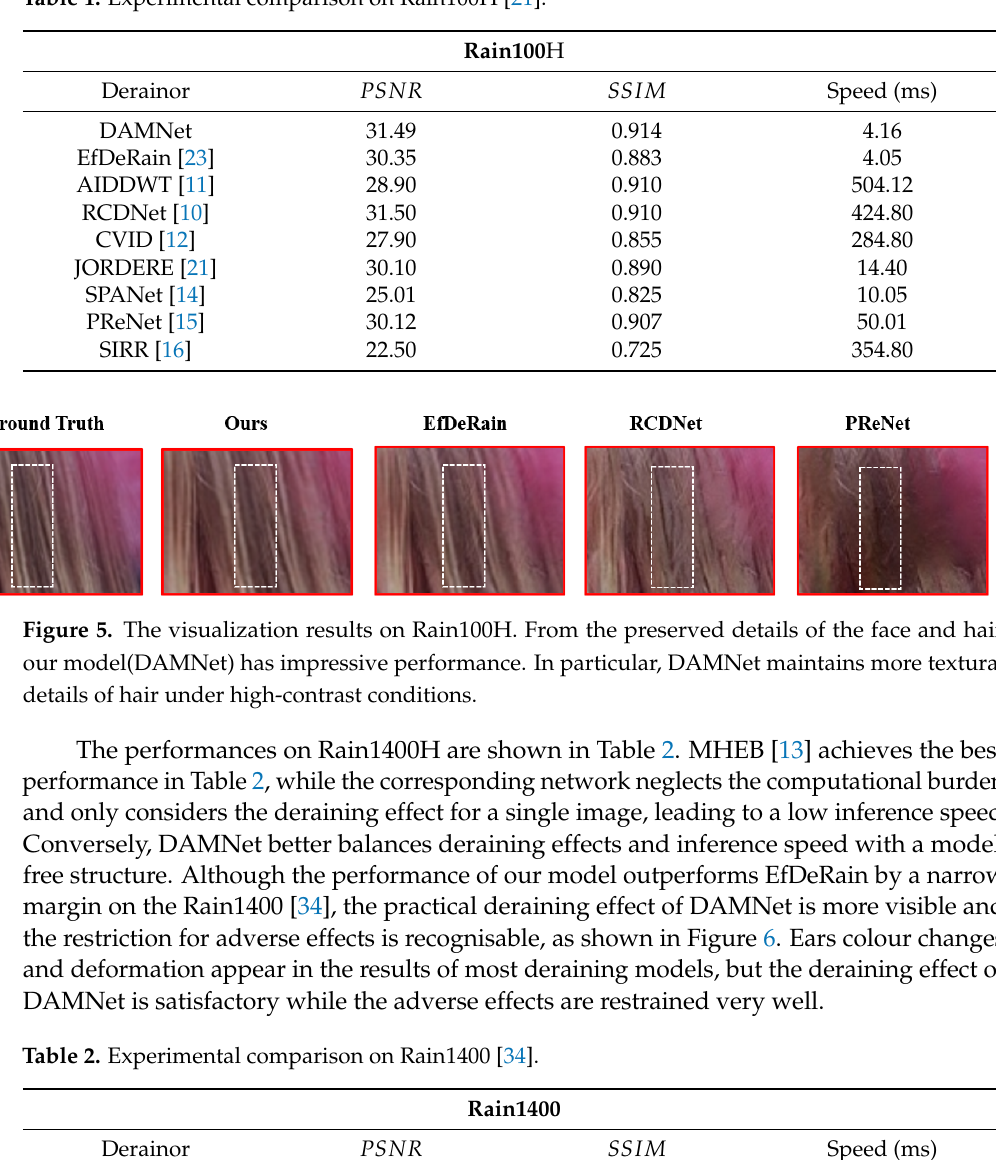
Table 1. Experimental comparison on Rain100H [21].